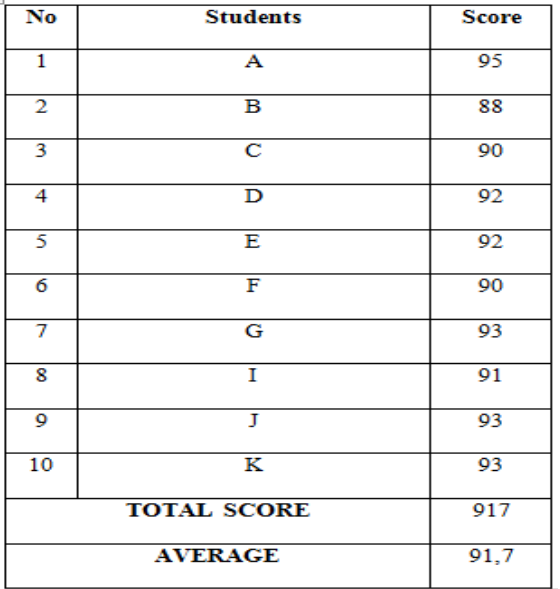
Table 3. The result of questionnaire